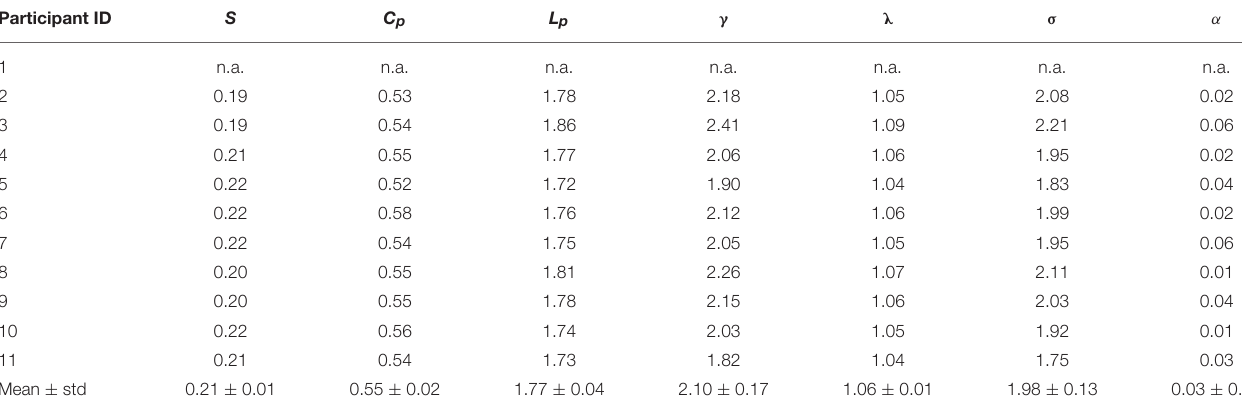
TABLE 3 | Summary of global properties of individual structural brain networks (AAL-90). Participant ID